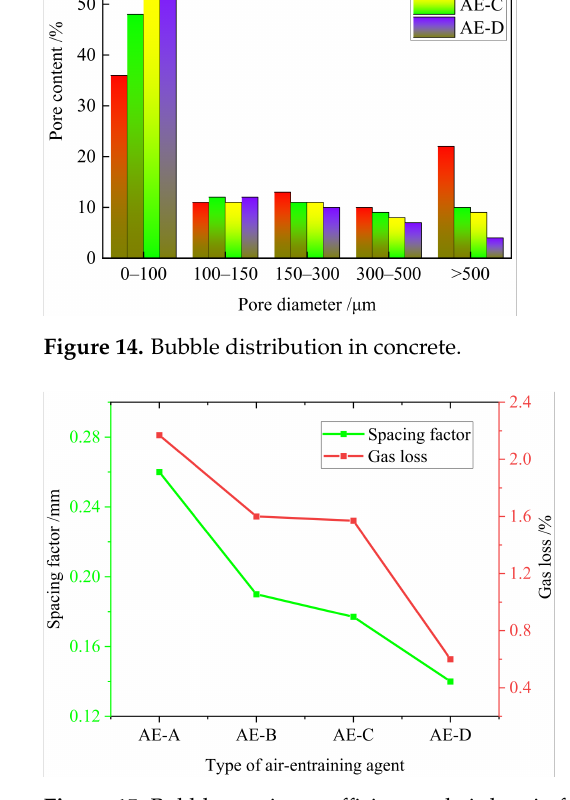
Figure 15. Bubble spacing coefficient and air loss in fresh